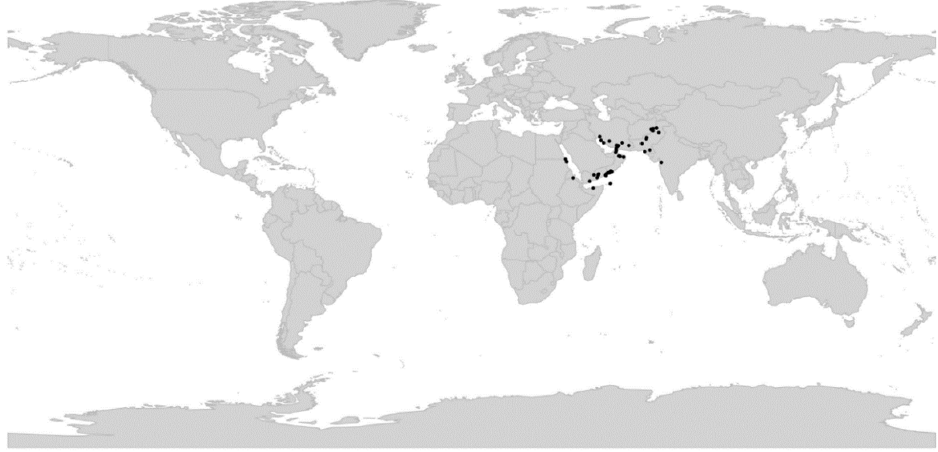
Figure 29. Global distribution of Viola sect. Sclerosium .